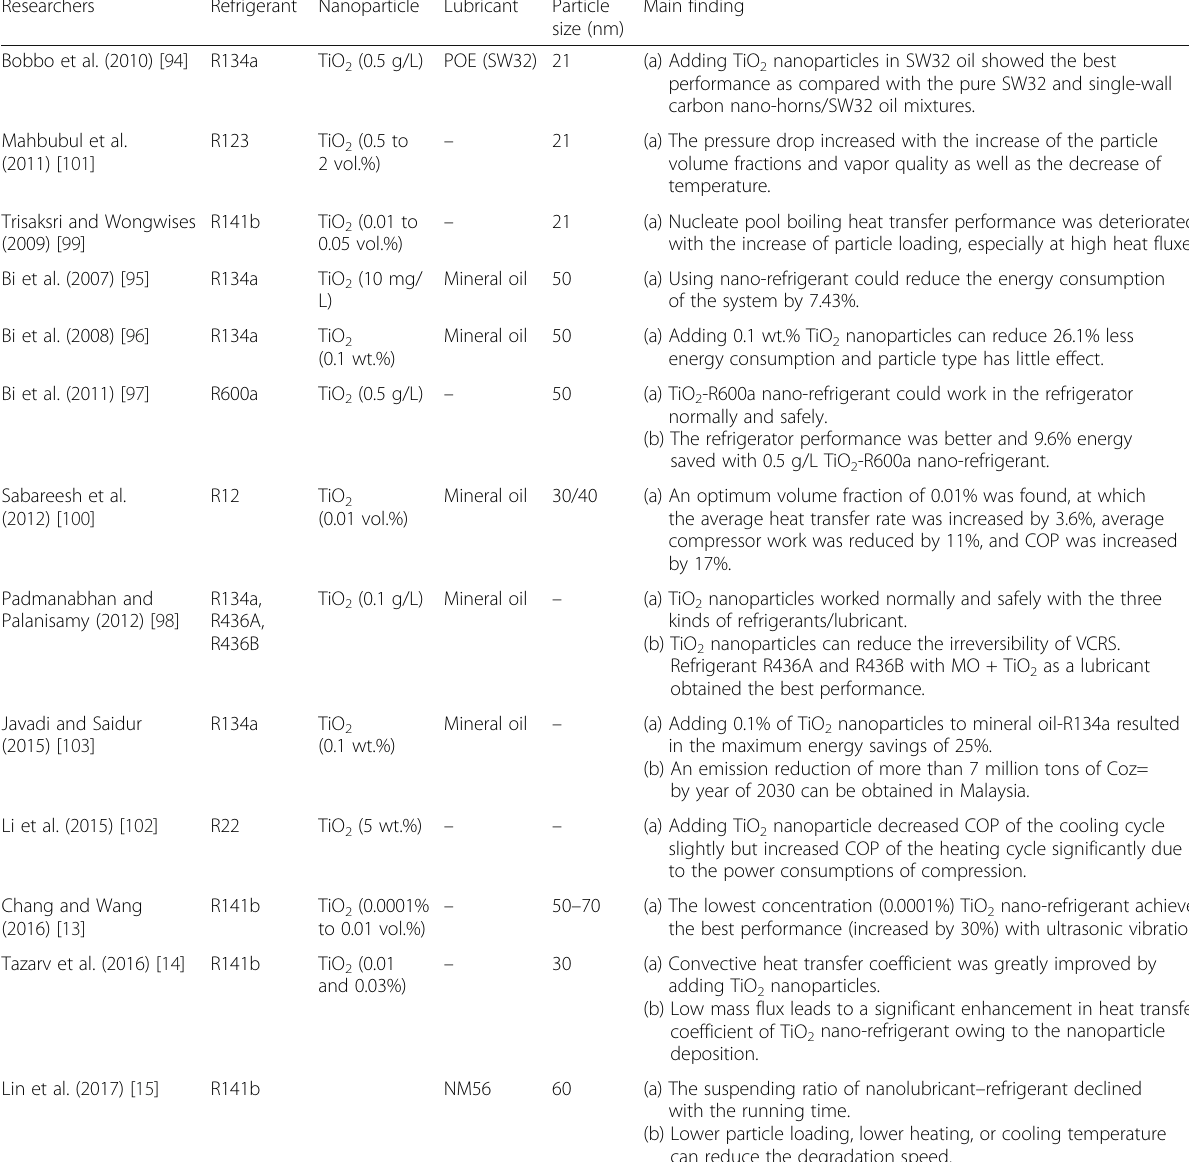
Table 2 Summary of related studies on TiO 2 nanoparticle-based nano-refrigerants Researchers Refrigerant Nanoparticle